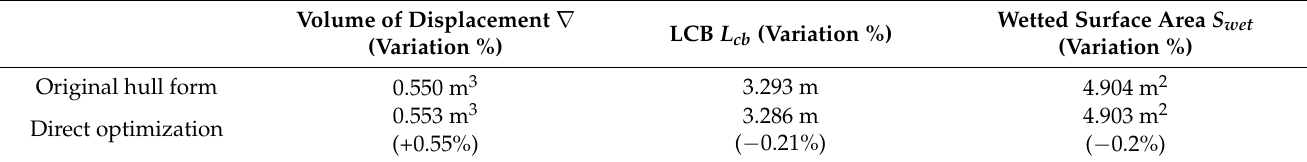
Table 7. Comparison of hydrostatic parameters of direct optimization.